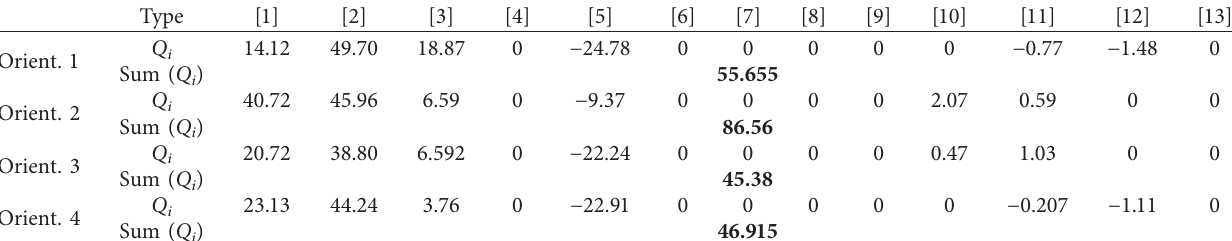
Table 8: GD&T objective function for orientations 1, 2, 3, and 4.